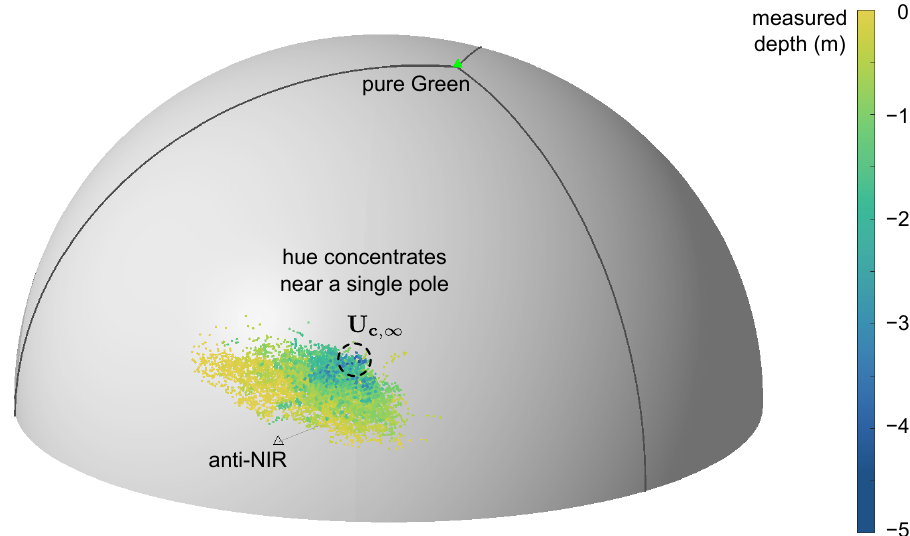
Figure 11. Representation of multispectral hue on S 2 for the pixels located at depth measurement points. As depth increases, hue tends to concentrate near a single pole corresponding to the hue of a very deep water column, denoted U c , ∞